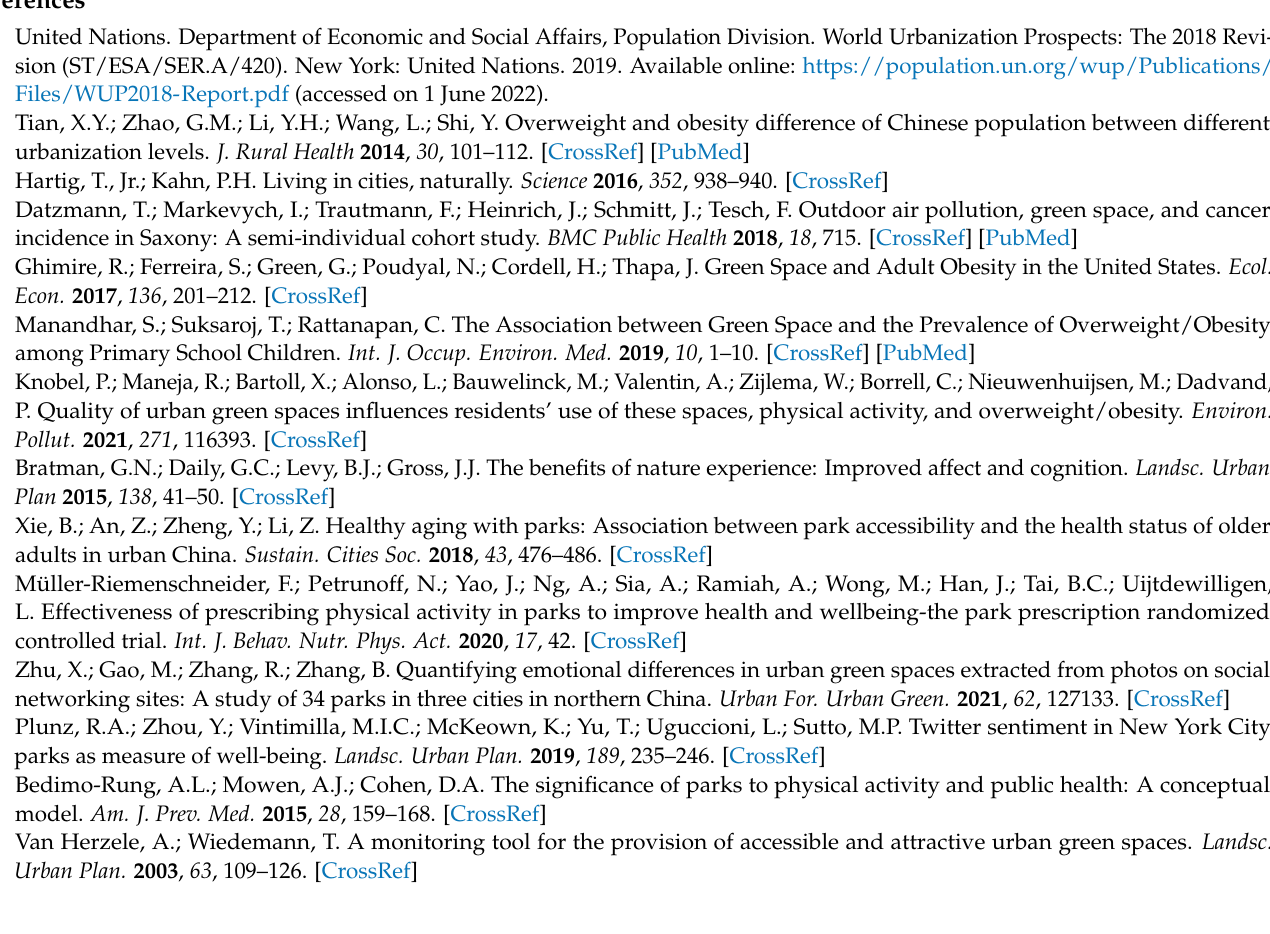
Table S3: Summary on barriers of visiting parks infrequently (less than once a month) by population